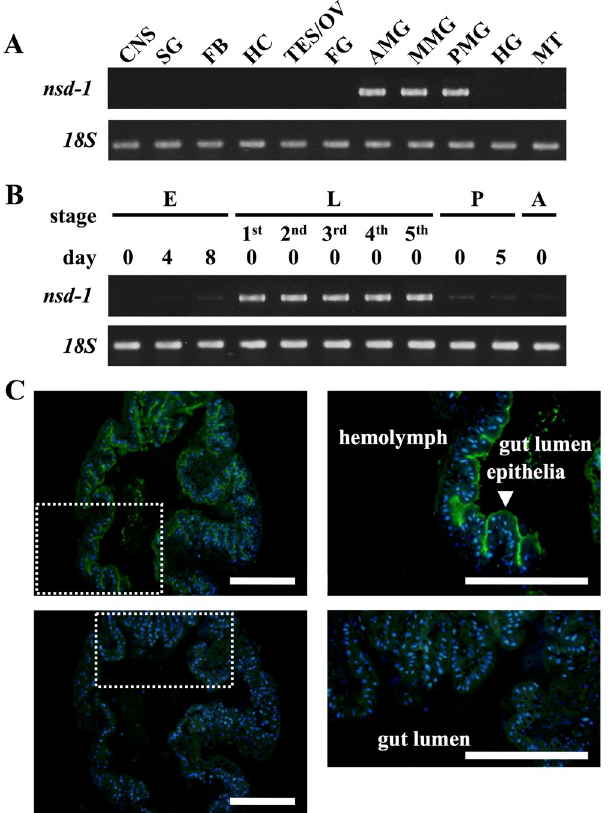
Figure 3. Expression profiles of nsd-1 . ( A ) Tissue-specific expression of nsd-1 in a resistant strain, p50T. CNS, central nervous system; SG, silk gland; FB, fat body; HC, hemocyte; TES/OV, testis and ovary; FG, foregut; AMG, anterior midgut; MMG, middle midgut; PMG, posterior midgut; HG, hindgut; MT, Malpighian tubule. Primer sets were designed to amplify nsd-1 (upper) and ribosomal 18S (lower) as a positive control. ( B ) Stage- specific expression of nsd-1 in the resistant strain p50T. E, eggs at on days 0, 4, and 8; L, whole larvae at on day 0 (first to fifth instar); P, whole pupae at on days 0 and 5; A, whole adult at on day 0. ( C ) Immunohistochemical analysis of NSD-1 in the larval anterior midgut. The upper panels show immunofluorescence visualization of NSD-1. The lower panels show control experiments with pre-immune serum. The right panels are zoomed-in images of the dotted boxes in the corresponding left panels. The sections were incubated with anti-NSD-1 antibody (1:200) or pre-immune serum followed by a secondary antibody labeled with AlexaFluor488 (1:200) (green) and counterstained with DAPI (1:1000) (blue). Scale bar: 200 μ